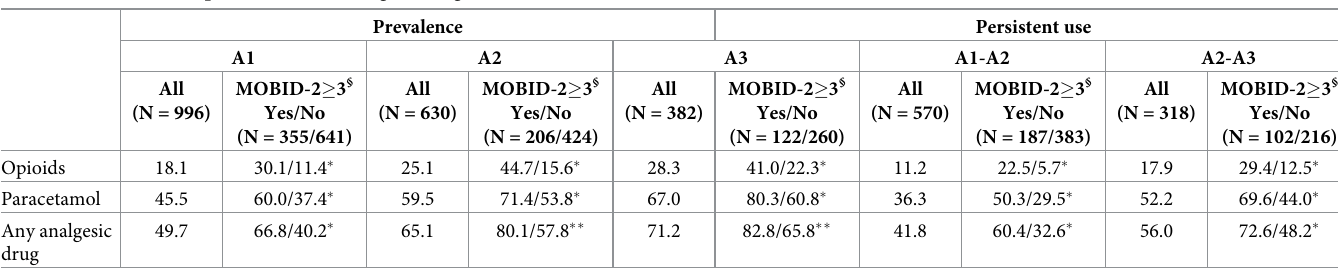
Table 2. Prevalence and persistent use of analgesic drugs.